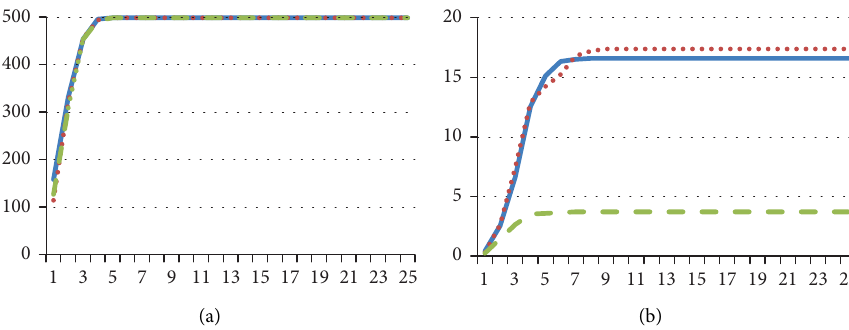
Figure 4: Comparison of the difusion of NEV with the diferent normative infuences of opinion leaders: (a) difusion of information and (b) difusion of products (the blue line represents experiment A , the red line represents group C